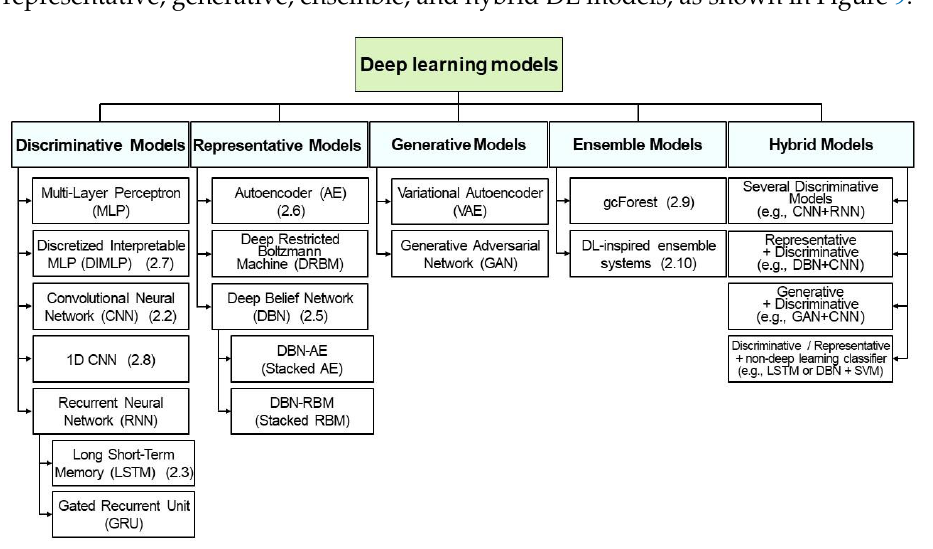
Figure 9. Taxonomy of deep learning models applied to credit scoring.